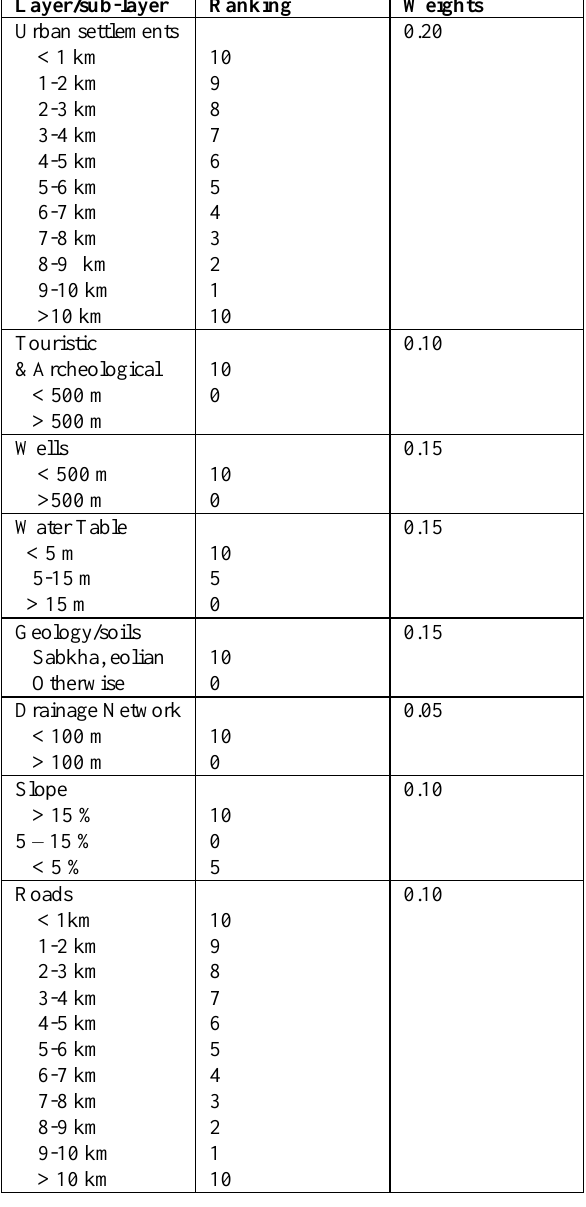
Table 3. Attribute ranking and Layer’s weights for the